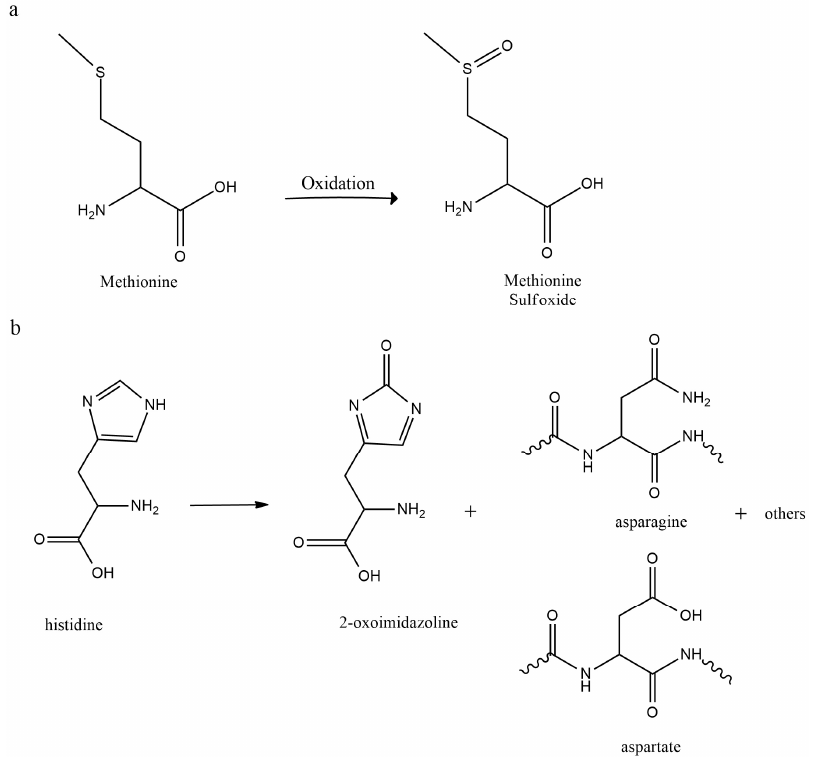
Figure 3. Oxidation reactions of Met and His: ( a ) oxidation by hydrogen peroxide to methionine sulfoxide in an acidic solution and ( b ) conversion of histidine to 2 ‐ oxo ‐ his, asparagine, and aspar ‐